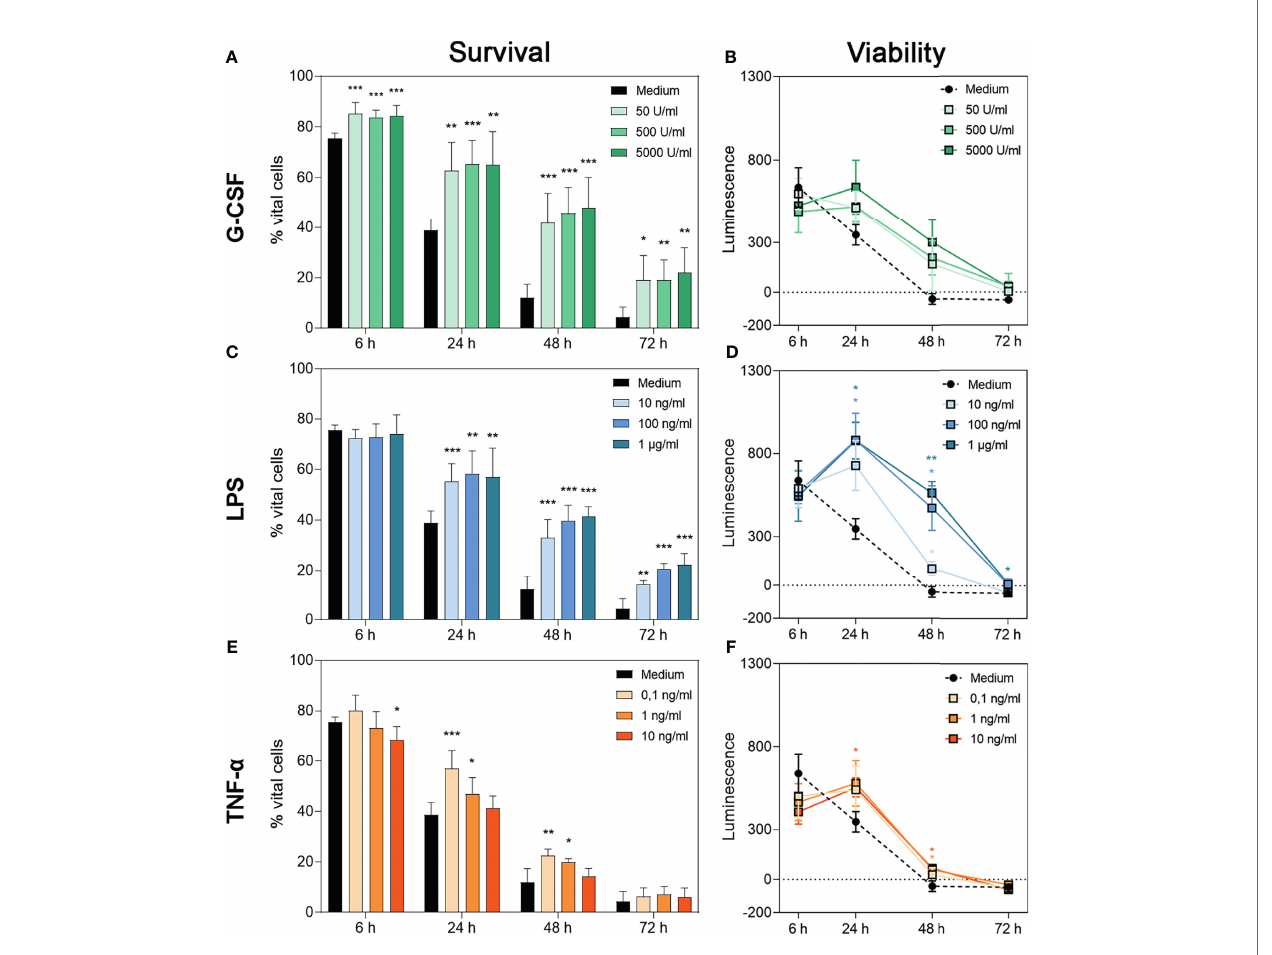
FIGURE 1 | Survival and metabolic activity of neutrophil granulocytes after treatment with G-CSF, LPS or TNF- a . Survival of neutrophils is represented by the percentage of PI- and Annexin V-double negative cells. Neutrophils were incubated with several amounts of G-CSF (A) , LPS (C) , TNF- a (E) or with only medium and analysed after 6 h, 24 h, 48 h and 72 h of incubation by FACS analysis. Values represent means ± SD of n = 6. Differences between the untreated control group and one treated group each were calculated individually using student ’ s t-test. Levels of signi fi cance were set at < 0.05 (*), < 0.01 (**), < 0.001 (***). Regulation of neutrophil viability was measured by bioluminescence. For this purpose, cells were cultured with luciferase and prosubstrate and incubated with G-CSF (B) , LPS (D) , TNF- a (F) or with only the medium for 6 h, 24 h, 48 h and 72 h. Values represent means ± SD of n = 3. Statistical signi fi cance for repeated measurements was analysed by ANOVA with Dunnett ’ s multiple comparison. Levels of signi fi cance were set at < 0.05 (*), < 0.01 (**), < 0.001